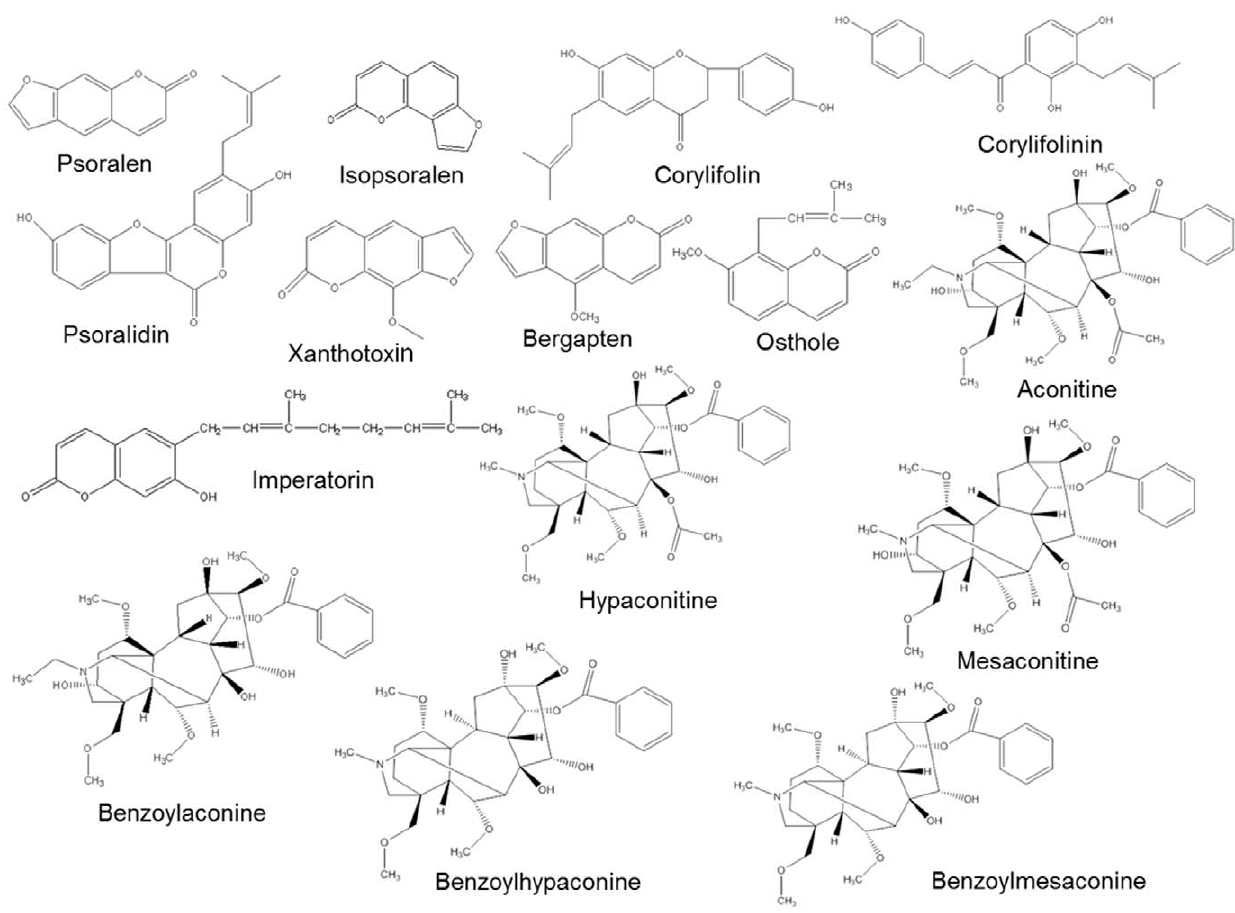
Figure 1. The chemical structures of 15 constituents in BZ.